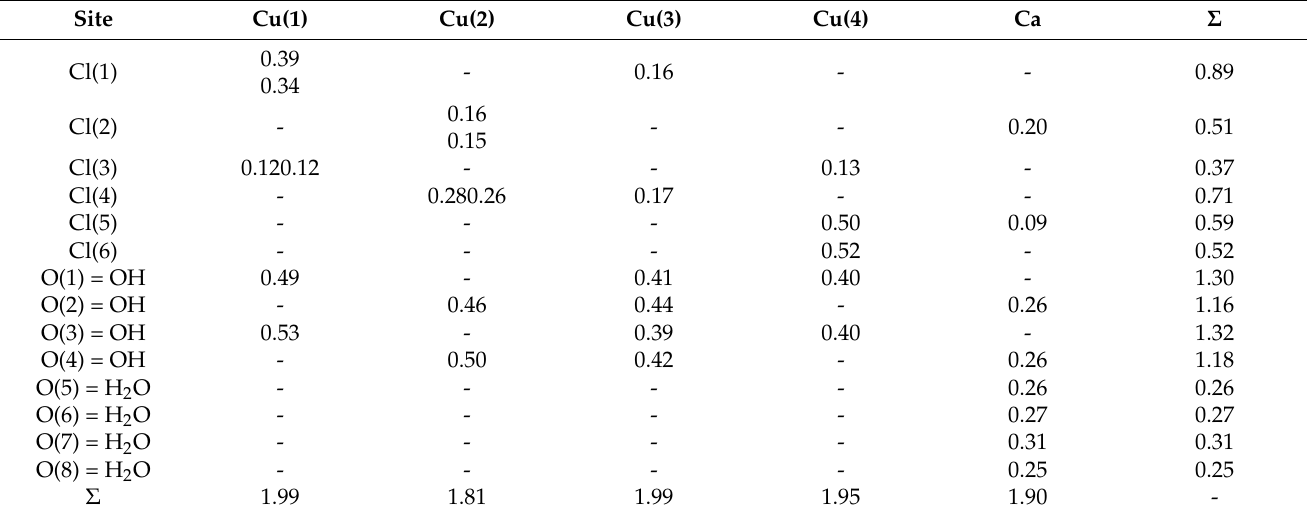
Table 8. Bond-valence calculations for dioskouriite-2 O